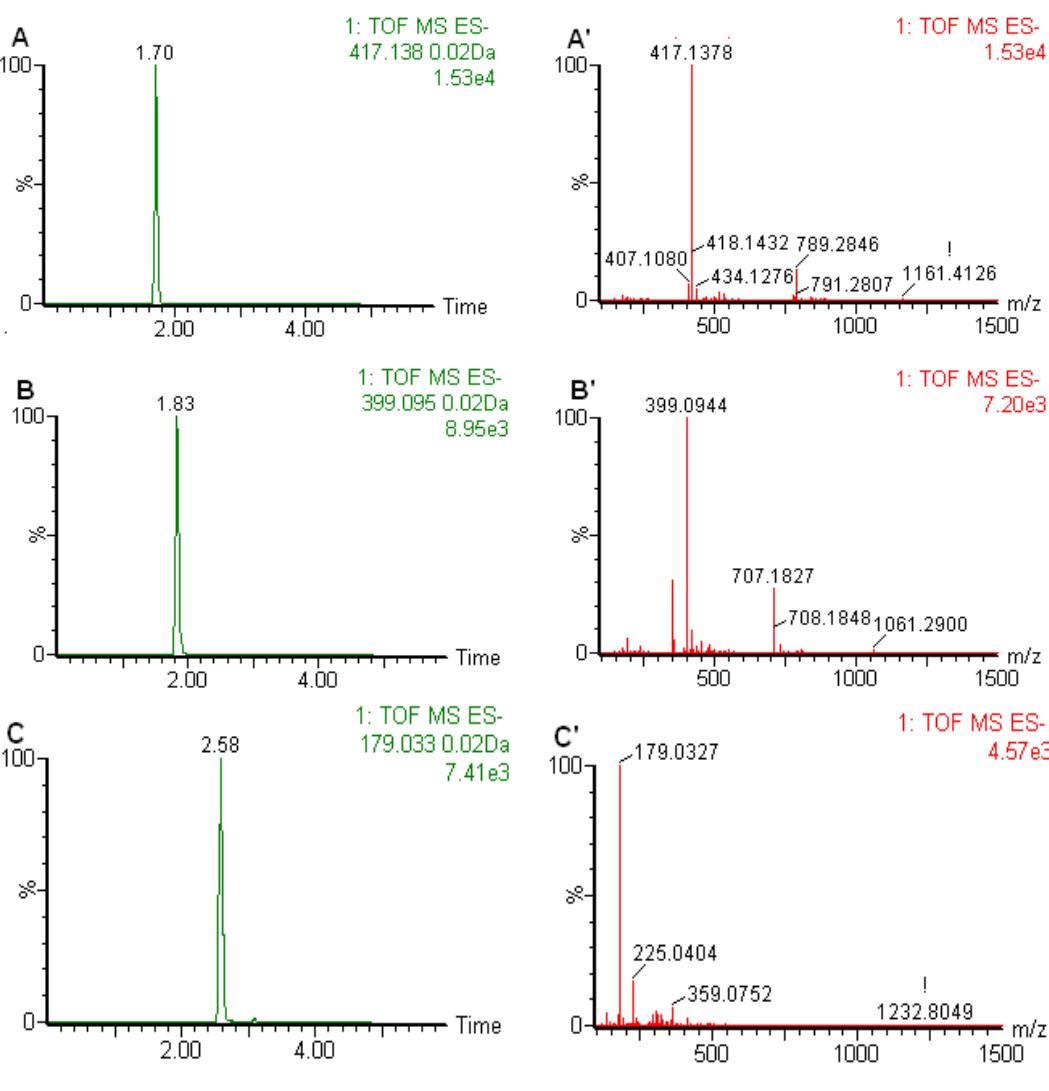
Figure 3. Representative nwXIC chromatograms of standard solutions (A–E) and corresponding mass spectrum (A'–E'). A and A', syringing; B and B', chlorogenic acid; C and C', caffeic acid; D and D', eleutheroside E; E and E',